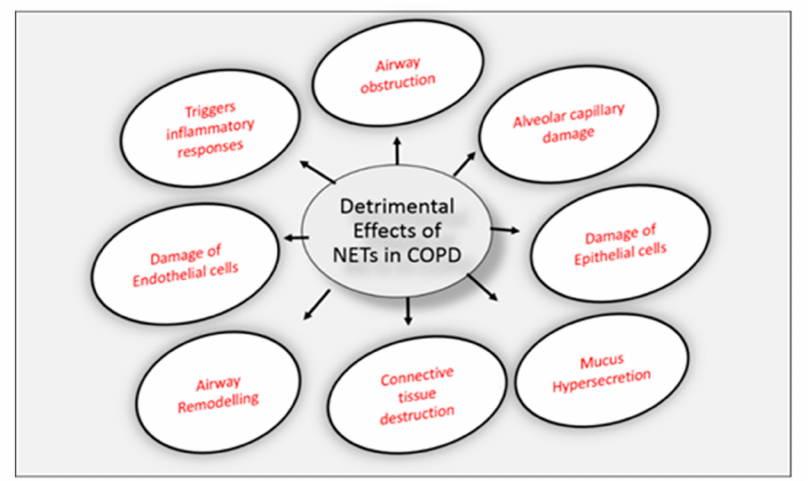
Figure 3. Detrimental effects of NETs in COPD: Inflammatory responses are triggered by elevated NETs in COPD and are associated with disease severity leading to airway obstruction, remodeling and mucus hypersecretion. NETs can also cause lung tissue damage by causing destruction of connective tissues and it also causes damage of alveolar capillaries, epithelial and endothelial cells. The genesis and structure of NETs was studied by Obermayer et al. from sputum of COPD patients [150]. Sputum of patients of all grades of COPD, stable and